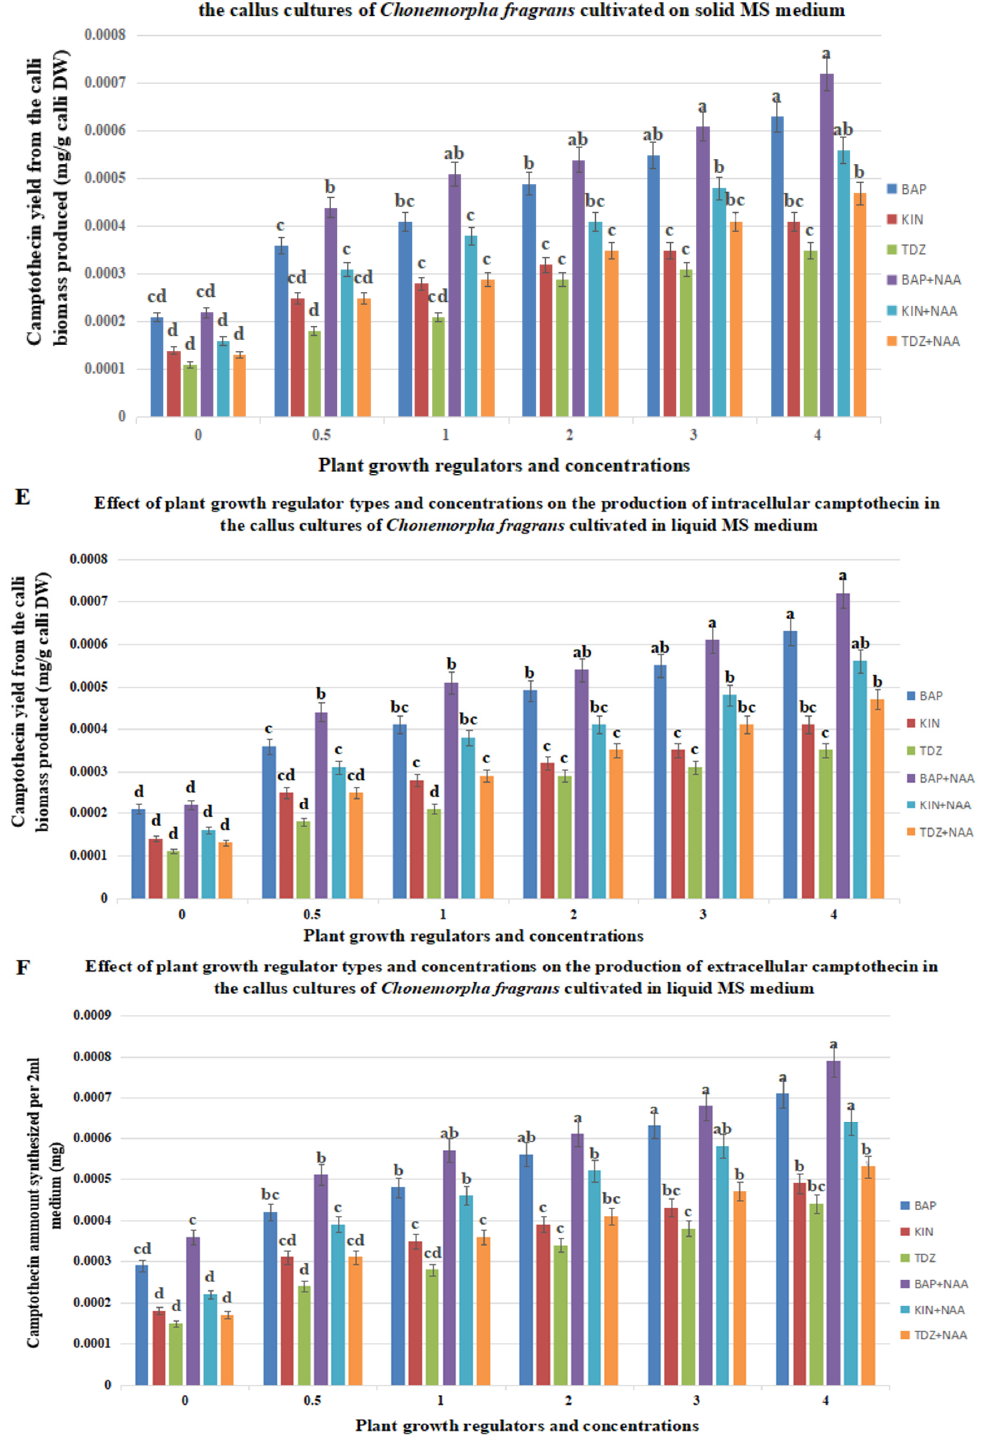
Figure 2. A-F evaluation of biomass and camptothecin production in the explants and resultant callus cultures of C.